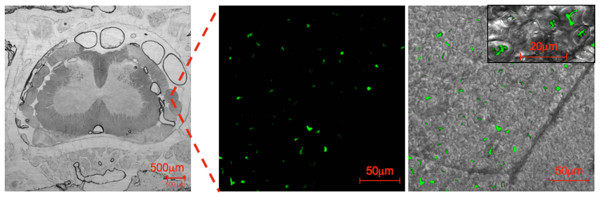
Cellular localization of transgene expression. Confocal microscopy demonstrated EGFP-expression in the nerve roots. The left panel provides an anatomic overview of a lumbar section through the spinal cord obtained with transmission light at a low magnification. The middle panel shows EGFP fluorescence (excitation wave length 488 nm, emission wave length 505–530 nm). The right image is a fusion of the fluorescence image with a transmission light micrograph of the same area. The insert depicts a detail at higher magnification. Images were obtained on an LSM 510 META confocal microscope.